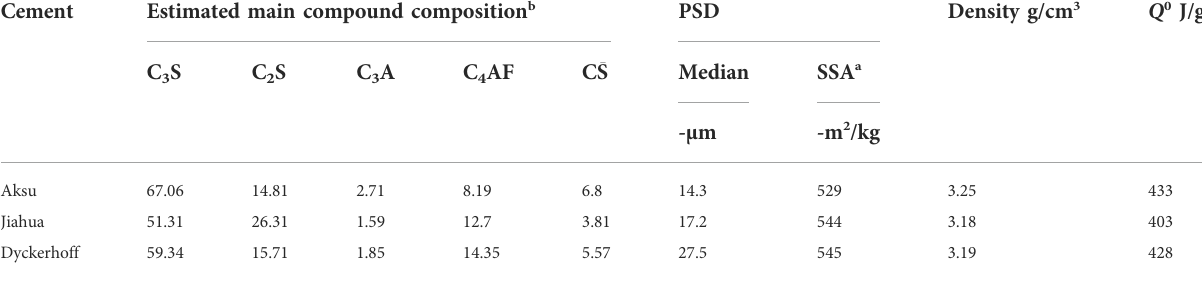
TABLE 1 Estimated main compound compositions (mass percentage) and other properties of different types of cements. Cement